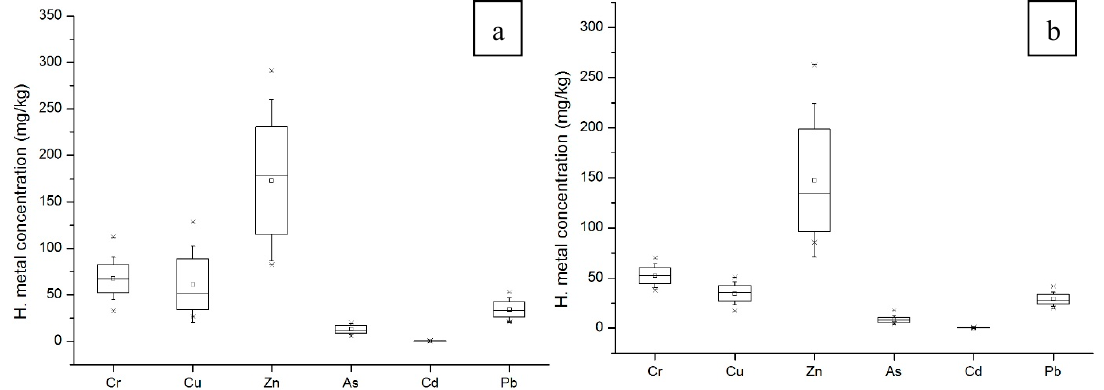
Figure 3. Box and whisker plots with standard deviation in soil in ( a ) dry season and ( b ) wet season.